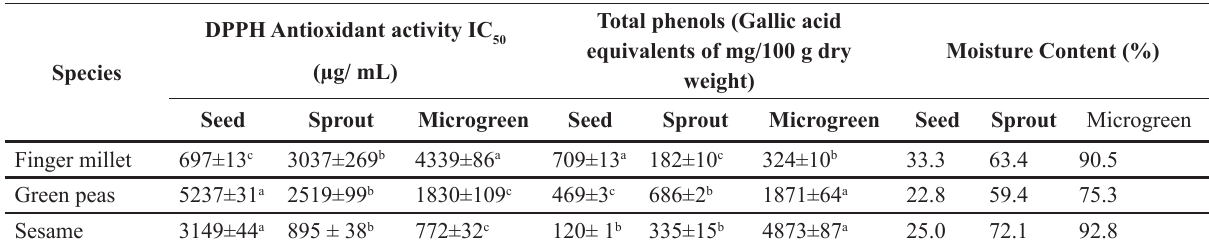
Table 3: DPPH (Diphenyl pycrylhydrazil) radical scavenging antioxidant activity expressed as (50% Inhibitory concentration) and total phenols content and moisture content of the selected three species of which seeds are consumed popularly in Sri Lanka.